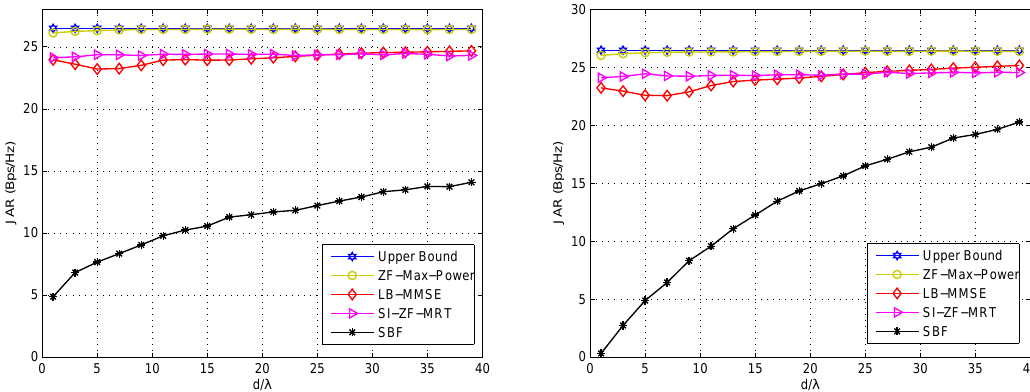
Figure 5. JAR performance of the involved schemes with respect to varying d under LOS channel in the case of separate arrays. ω = π rad. In the ( Left ) hand figure SI is assumed fixed, i.e., ε 11 = ε 22 = 40 dB, ε 12 = ε 21 = 10 dB; while in the ( Right ) hand figure SI varies with d / λ , ( d / λ ) dB, ε = ε = 10 i.e., ε 11 = ε 22 = 60 − 20log 12 21 10